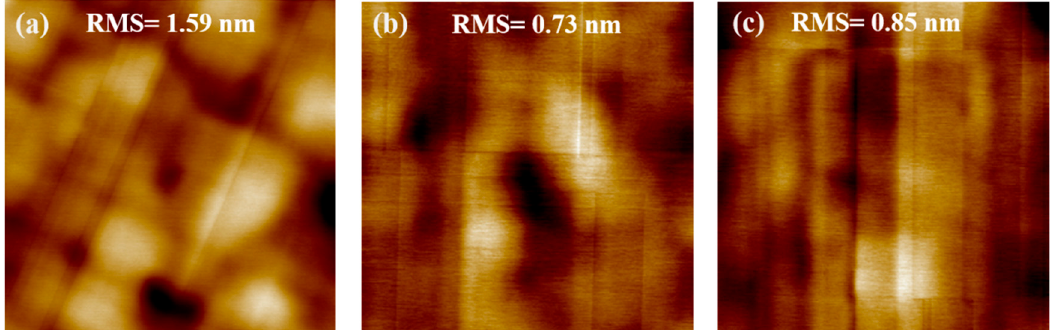
Figure 3. AFM images (10 × 10 µm 2 ) of Si 0.2 Ge 0.8 /Ge multilayers grown on ( a ) 0.6, ( b ) 1.2 and ( c ) 2.0 µm thick Ge buffer layers. The estimated RMS for surface roughness values of these samples are 1.59, 0.73 and 0.85 nm, respectively.